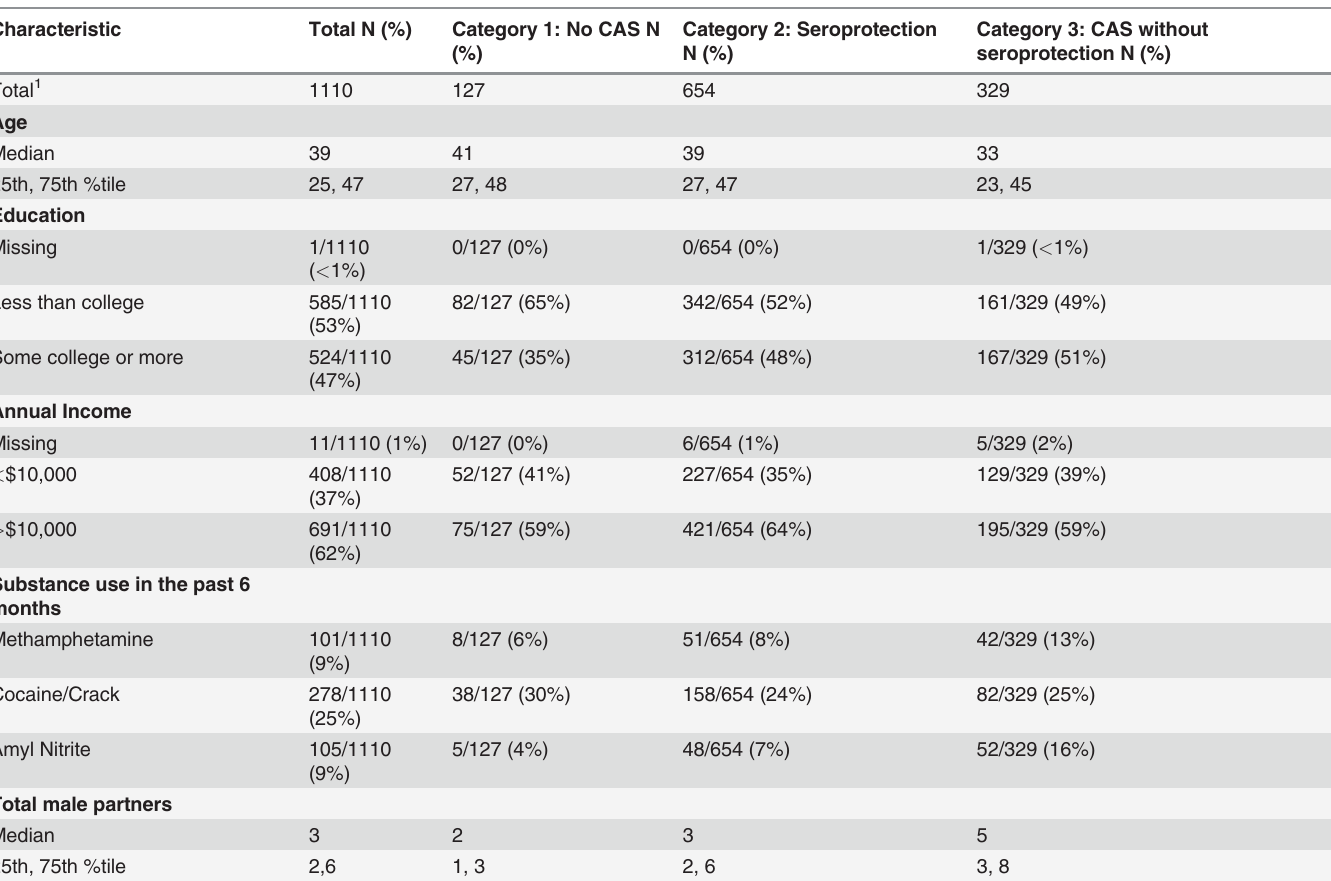
Table 1. Demographic and behavioral characteristics of HPTN 061 participants by seroprotective behavior at baseline. Characteristic